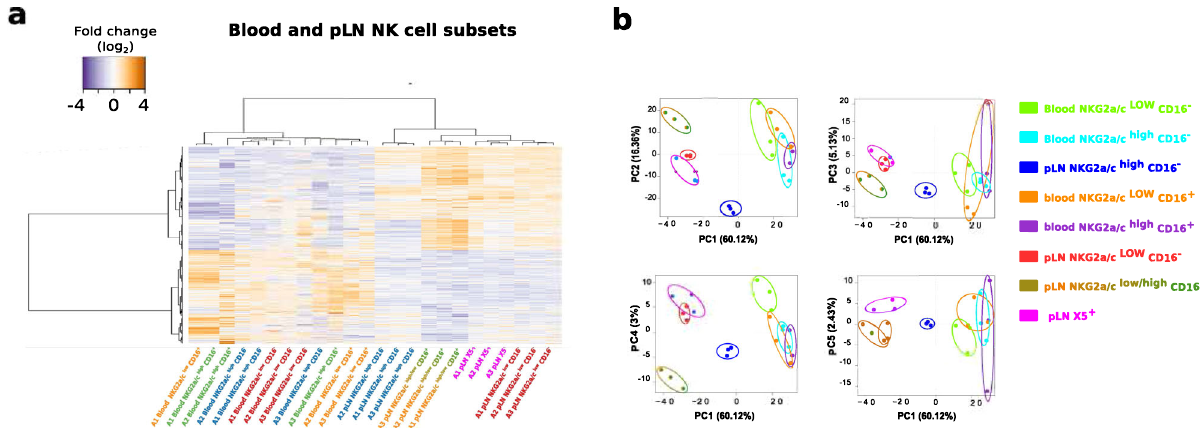
Fig. 4 Deep transcriptional differences between blood and pLN NK cells subsets during chronic SIVagm infection. a Heatmap showing the 5,489 genes differentially regulated between blood and LN NK cells in chronically SIVagm-infected AGM. The orange and blue colors indicate higher and lower levels of transcripts measured in blood and LN NK cell subsets from three chronically infected monkeys Each row represents a variable gene among clusters, and each column represents the NK cell subset for an individual monkey. The NK cell subsets are indicated in distinct colors. NK cell subsets are organized based on the overall similarity in gene expression patterns by an unsupervised hierarchical clustering algorithm of variable genes. A dendrogram, in which the length of the branches re fl ects the comparative difference in gene expression pro fi les between each of the NK samples is shown. A p -value adjustment was performed to account for multiple comparisons and control the false positive rate to a chosen level. The transcriptome similarity among clusters of the blood sample was evaluated by the Euclidean distance. P values ≤ 0.05 were considered statistically signi fi cant. Source data been deposited in the Gene Expression Omnibus database; the accession number is GSE140600. b Clustering of samples using the fi rst fi ve principal components (PC) of the indicated subset with percentages of variance associated with each axis based on the mean expression of the genes with variable expression. Each dot represents one monkey and circle around the dot represents one NK